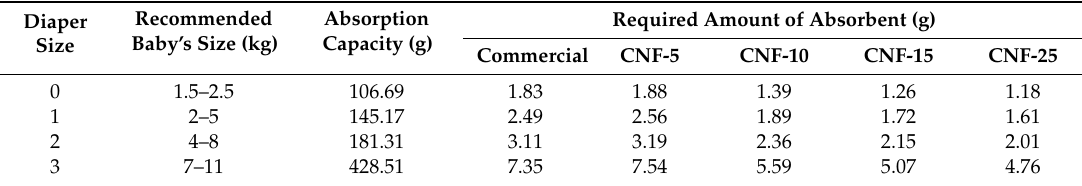
Table 2. Absorption capacity of commercial diapers and the required amount of CNF at each oxidation